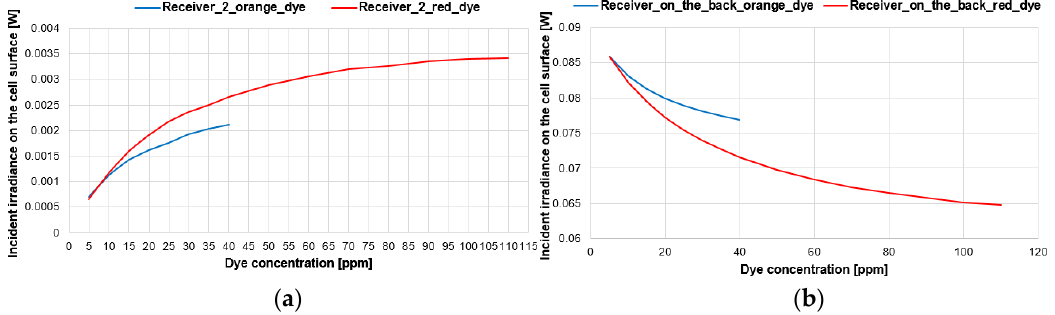
Figure 6. A comparison of the direct incident irradiance on the solar cells in LSC PV design Configuration 2—see Table 1—under exposure to standard test conditions (STC) irradiance (1000 W/m 2 , 100% direct) for the case of the orange and the red dyes: ( a ) the solar cell surface in between the lightguides; ( b ) the solar cell surface at the back.